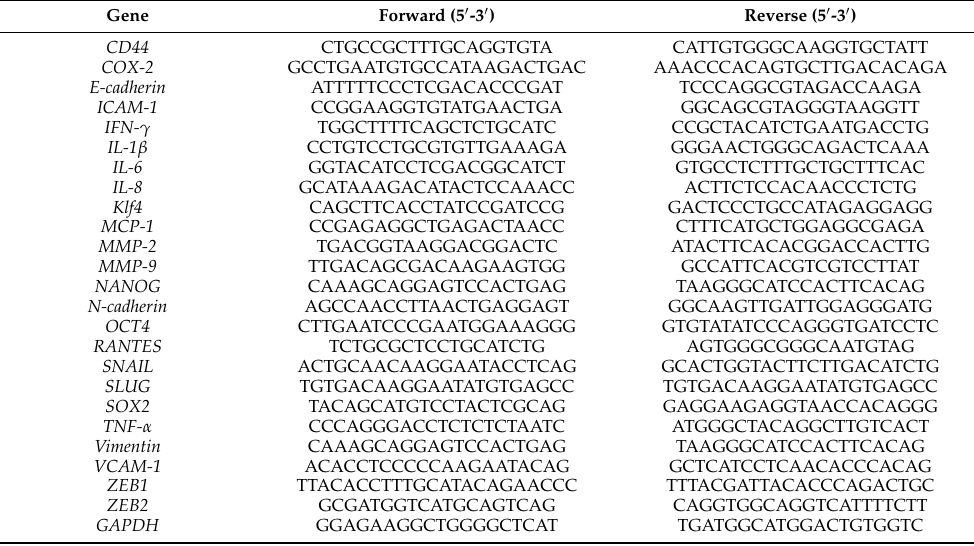
Table 1. qRT-PCR primer names and their sequences.